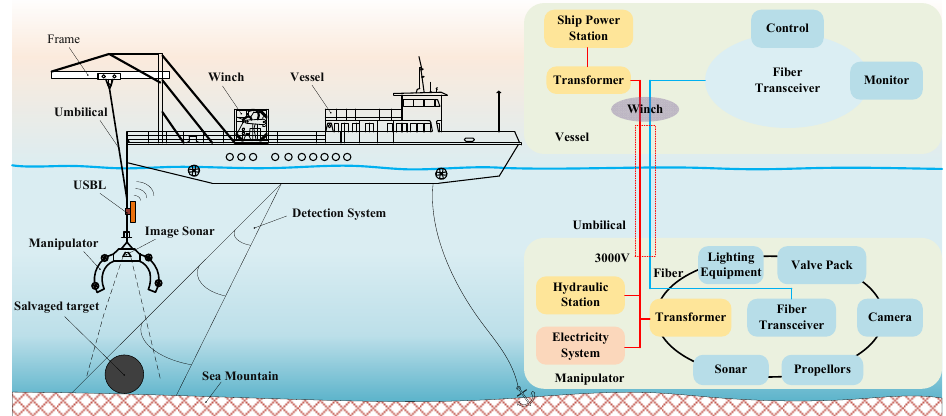
Figure 13. The rapid salvage system ( Left ); the control system ( Right ). As shown in Figure 13, the rapid salvage system consists of the manipulator, the umbilical system, and the support